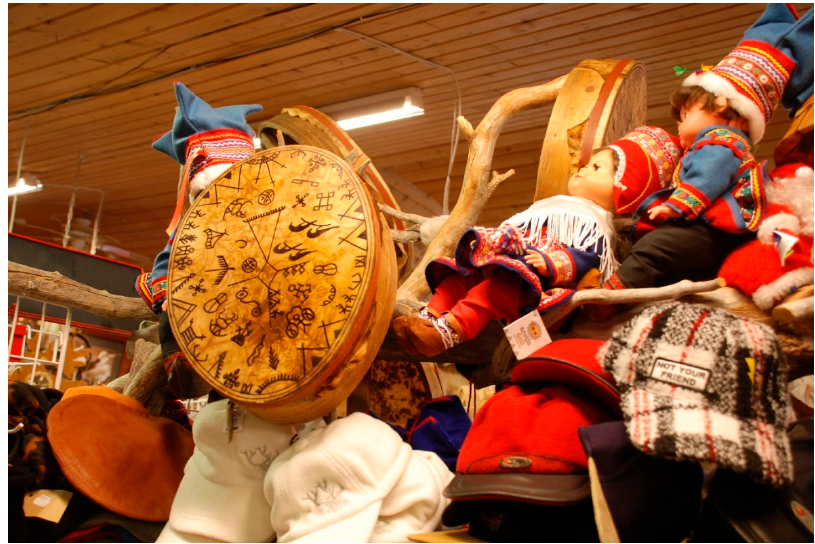
Figure 1. ‘Sámi magic drum’ with dolls in Sámi dresses, and other souvenir items in countryside Figure 1. ‘S á mi magic drum’ with dolls in S á mi dresses, and other souvenir items in countryside souvenir shop in Alatalo, Finland, June 2019. Photo by the